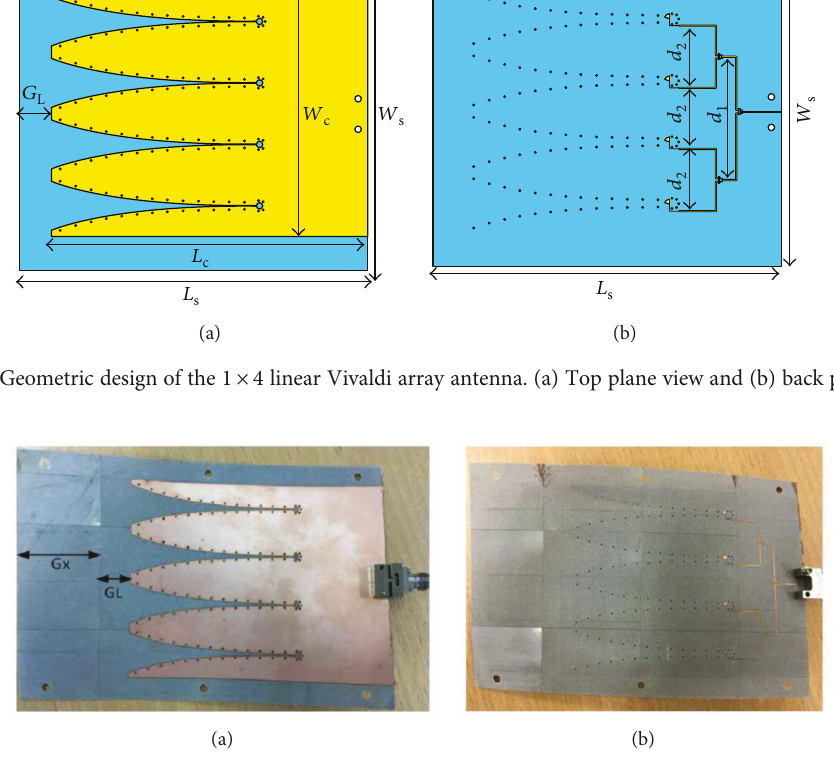
Figure 8: Realized prototype of the 1 × 4 linear Vivaldi array integrated with WPD acting as feed network. (a) Top plane view and (b) back plane view. Table 4: Optimized parameters of the 1 × 4 linear Vivaldi antenna array.